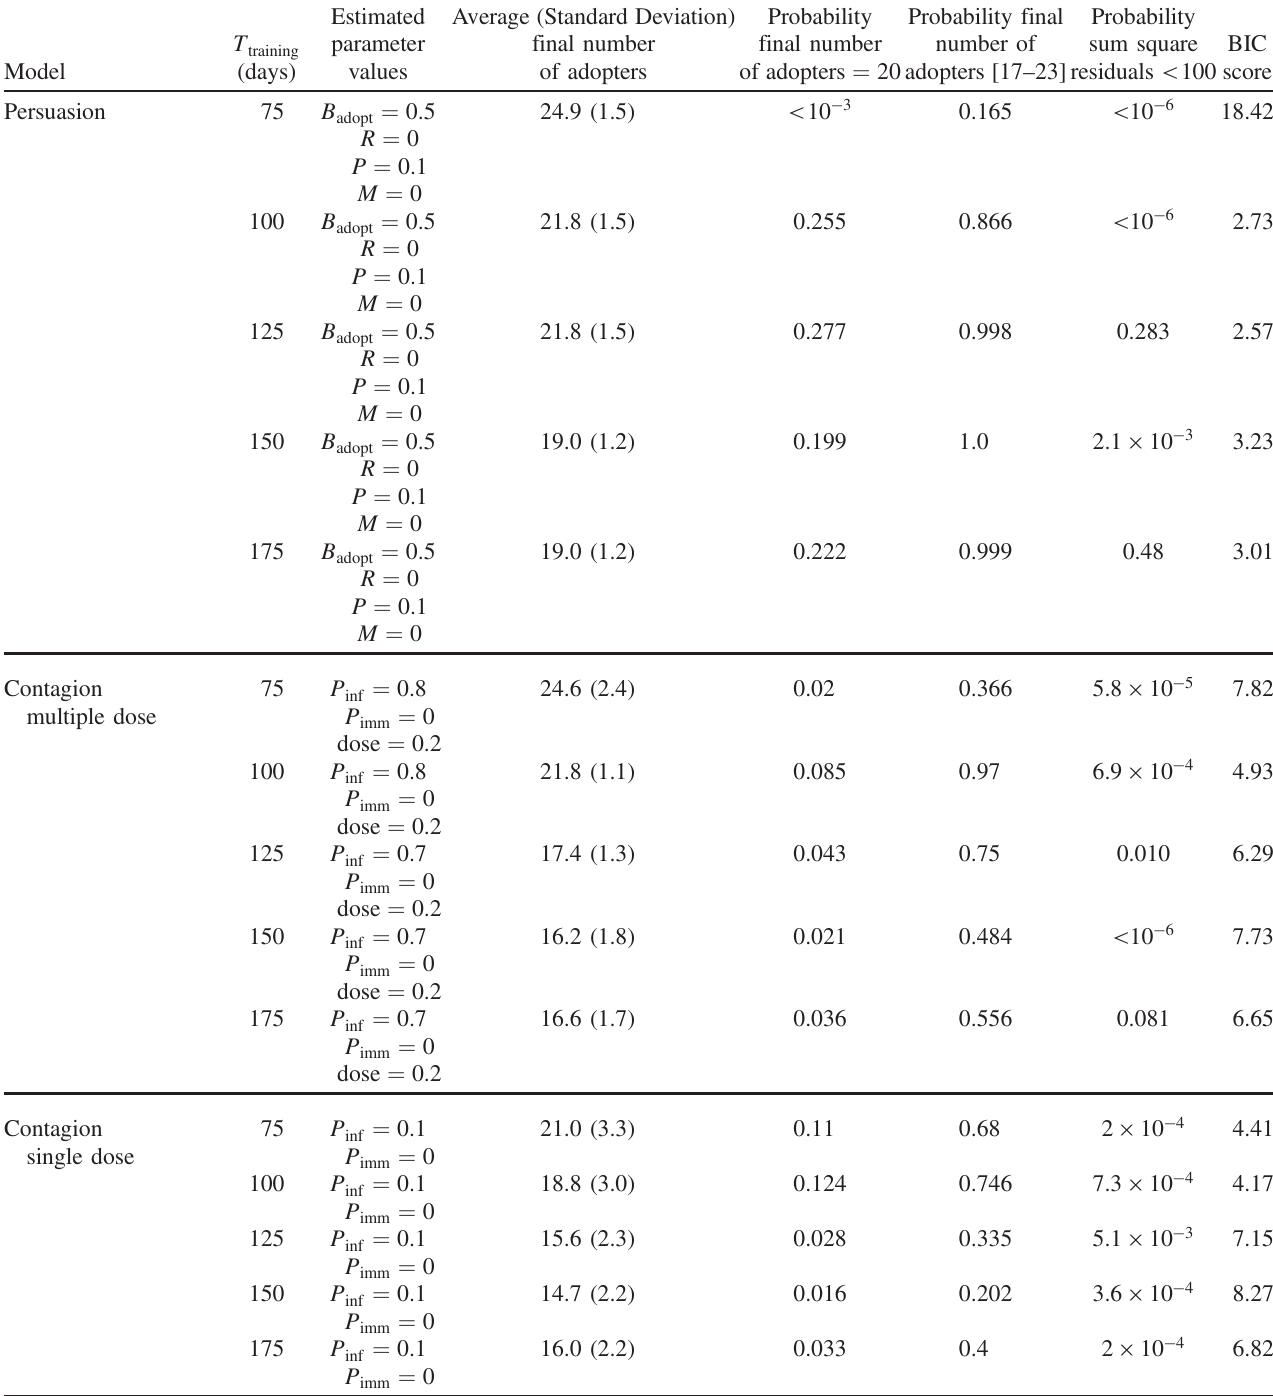
TABLE I. Summary of performance for all models and for different lengths of the training segment. Recall that the final number of adopters in the experiment is 20. BIC refers to the Bayesian information criterion. Probability < 0 . 05 indicates that the model is not compatible with the experimental data. Lower BIC values indicate that the model provides a better description of the experimental data for the same value of T . The persuasion model performs significantly better than the contagion models in all the metrics, and also training for any training periods equal to or longer than 100